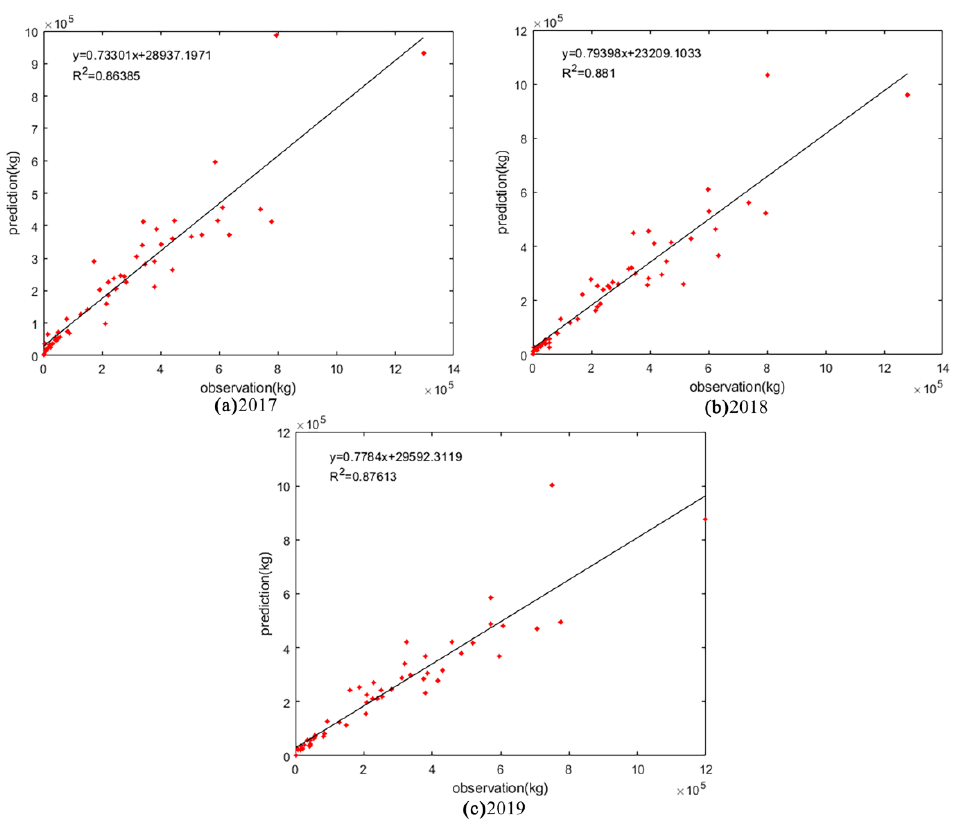
Figure 7. Scatter plots of predicted and observed yield from 2017 to 2019.